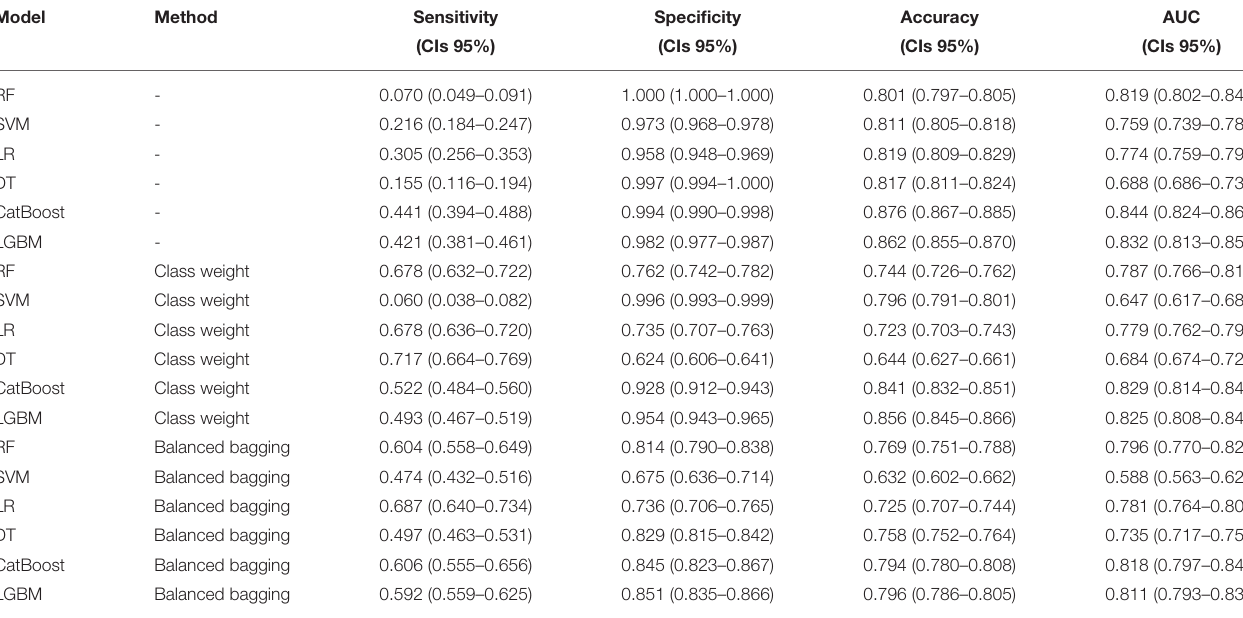
TABLE 2 | Comparison of the predictive performance for six models (cross-validated data).